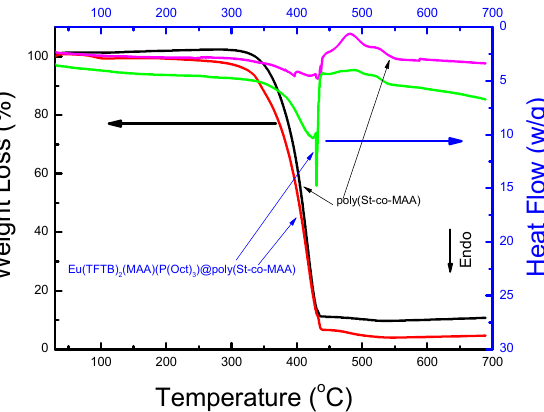
Figure 3. Thermal degradation profile and DSC curve of poly(St- co -MAA) and Eu(TFTB) 2 (MAA)P(Oct) 3 @poly(St- co -MAA) particles. The secondary weight loss and heat flow curve of Eu(TFTB) 2 (MAA)P(Oct) 3 @poly(St- co -MAA) over the temperature range of 200 ◦ C to 527 ◦ C is due to the thermal decompo- sition of organic compounds such as MAA, TFTB and P(Oct) 3 . The heat of the reaction increased due to the disintegration of the β -diketonate Eu 3+ complexes on poly(St- co -MAA). Eu(TFTB) 2 (MAA)P(Oct) 3 @poly(St- co -MAA) has a lower decomposition temperature than poly(St- co -MAA), which means better thermal conductivity [19]. The sharp endothermic peak in the DSC curve of Eu(TFTB) 2 (MAA)P(Oct) 3 @poly(St- co -MAA) at 430 ◦ C can be assigned to the thermal decomposition of P(Oct) 3